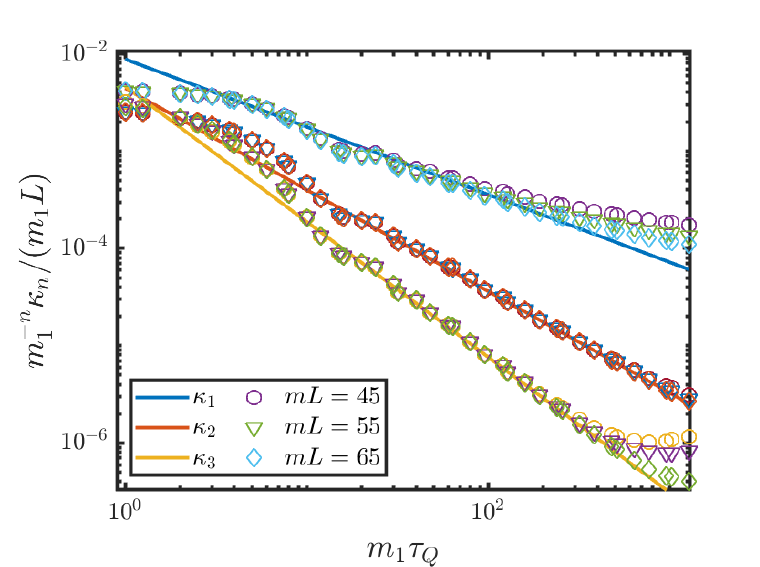
Figure 5.2: Cumulant densities for ECP ramps on the E extrapolated TCSA data and the expected KZ scaling from dimension counting. The scaling exponents are 16 / 23, 24 / 23 and 32 / 23,